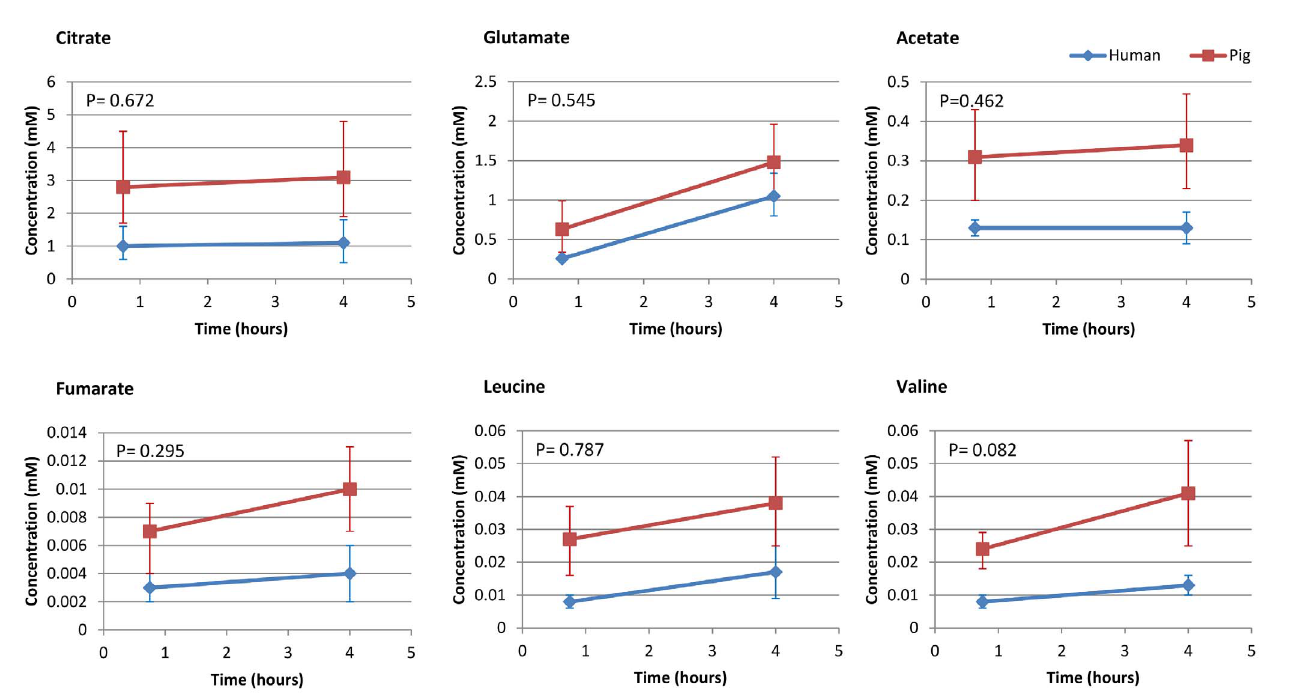
Fig. 3. Comparable rate of change of concentration demonstrated for depicted metabolites during 4 hours of HMP despite absolute interspecies concentration